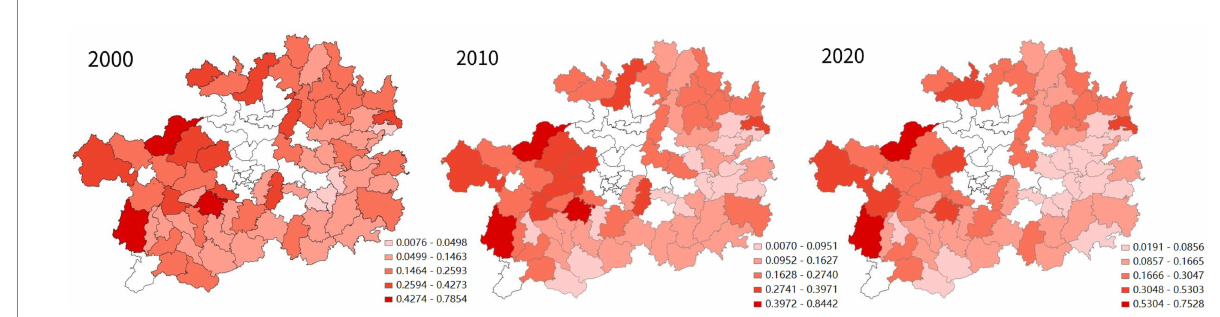
FIGURE 4 Spatial analysis of changes in the economic QoL of Guizhou’s districts and